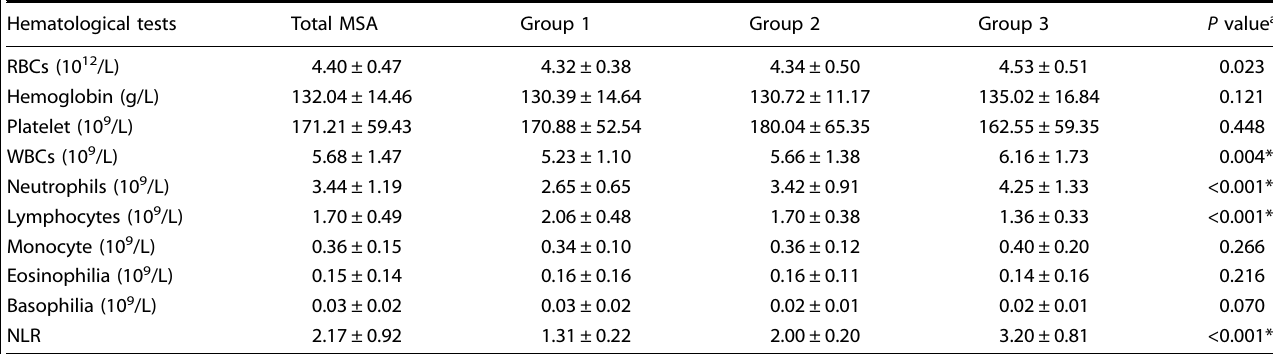
Table 3. Hematological data of patients with MSA between the three groups according to NLR tertiles.